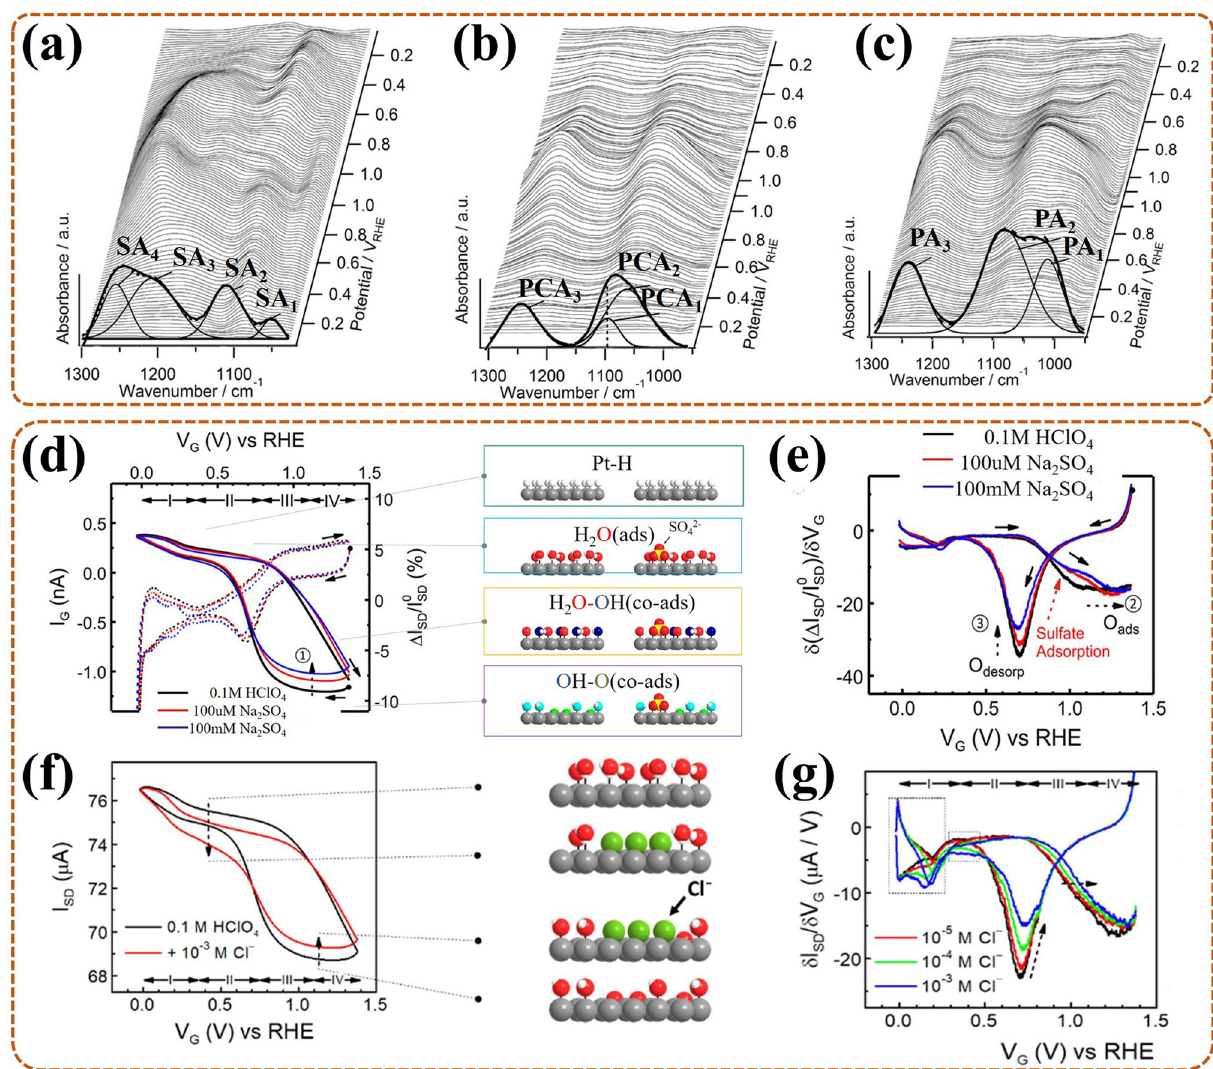
Fig. 13 In-situ ATR-FTIR waterfall plots on Pt/C during ORR and with corresponding deconvolution by Gaussian fitting at 0.07 V, a in 0.5 M H 2 SO 4 and for (bi)sulfate adsorption, b in 0.5 M HClO 4 and for ClO 4 adsorption, c in 0.5 M HClO 4 + 10 mM H 3 PO 4 and for relative adsorption [136]; Reused with approval; Copyright 2016 WILEY–VCH Verbg GmbH&Co. KGaA, Weinheim. d In-situ ETS curves (solid lines) and cyclic voltammetry curves (dash lines, without explain in this paper) of sulfate adsorptions on PtNW surface, with schematic of surface adsorption models in right side, with Pt (gray), H (white), O (red, in H 2 O ads ; blue, in OH ads ), e dETS curves in 0.1 M HClO 4 and 100 uM/100 Mm NaSO 4 ; f In-situ ETS curves of chlorides adsorption, also with modes schematic in right side, with Pt (gray), H (white), O (red), Cl (green); g dETS curves with changing chloride concentrations; All dashed arrows for the influence of sulfates/chlorides adsorption on the varies of ETS or dETS [103]. Reused with approval; Copyright 2018 American Chemical Society. (Color figure